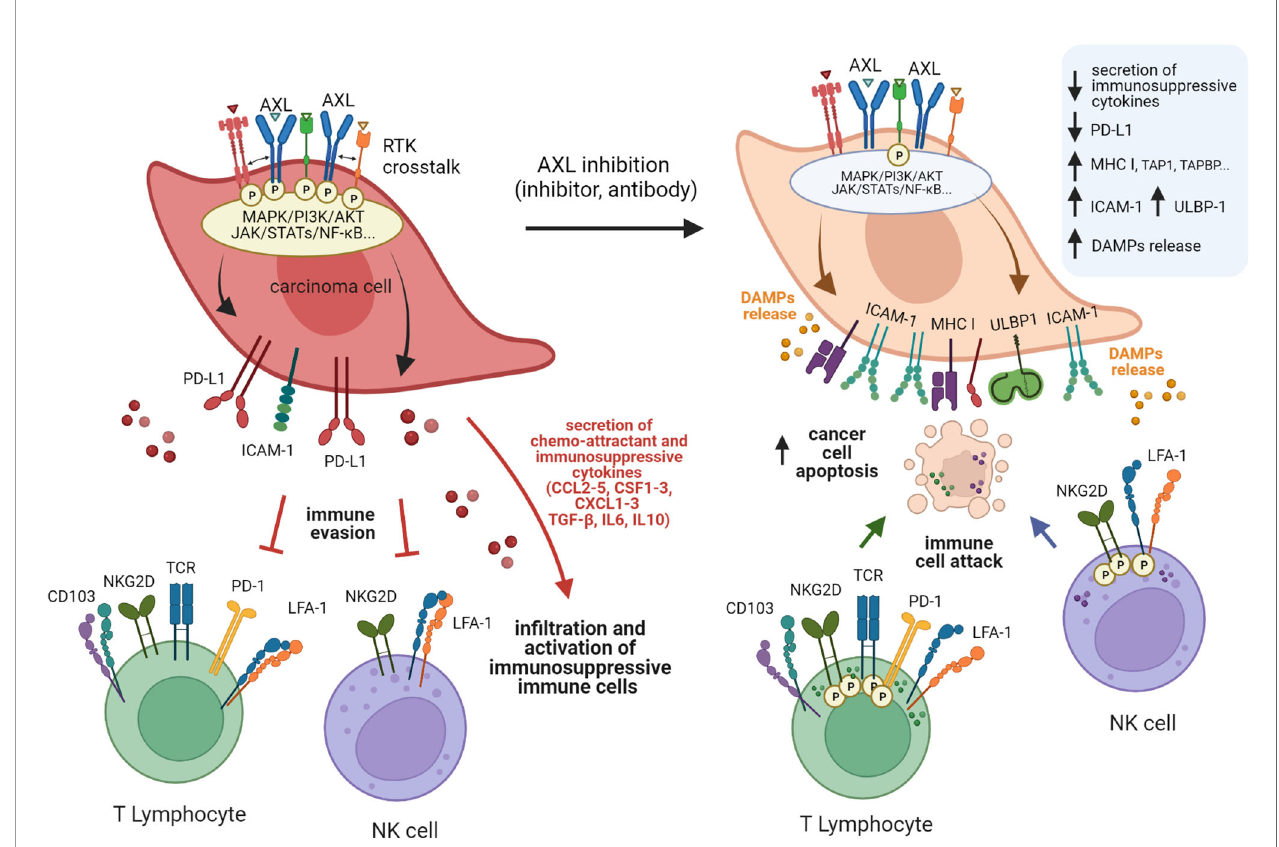
FIGURE 4 | Schematic model of AXL-mediated mechanisms of immune escape and the various facets of immunosenzitisation induced by targeting AXL. High AXL expression endows cancer cells with the ability to evade immune-mediated recognition and killing through multiple mechanisms. Cancer cells with active AXL signaling generally express more PD-L1 but less MHC class I molecules, ICAM-1, and NKG2D ligands than cells with inactive or reduced AXL signaling. These characteristics are associated with reduced recognition and elimination by cytotoxic lymphocytes. These cells also secrete an array of cytokines that attract immunosuppressive cell populations or directly inhibit cytotoxic immune cells, further limiting immune responses. Targeting AXL may partially reverse this phenomenon and sensitize carcinoma cells to immune attacks, while amplifying immune responses through the induction of immunogenic cell